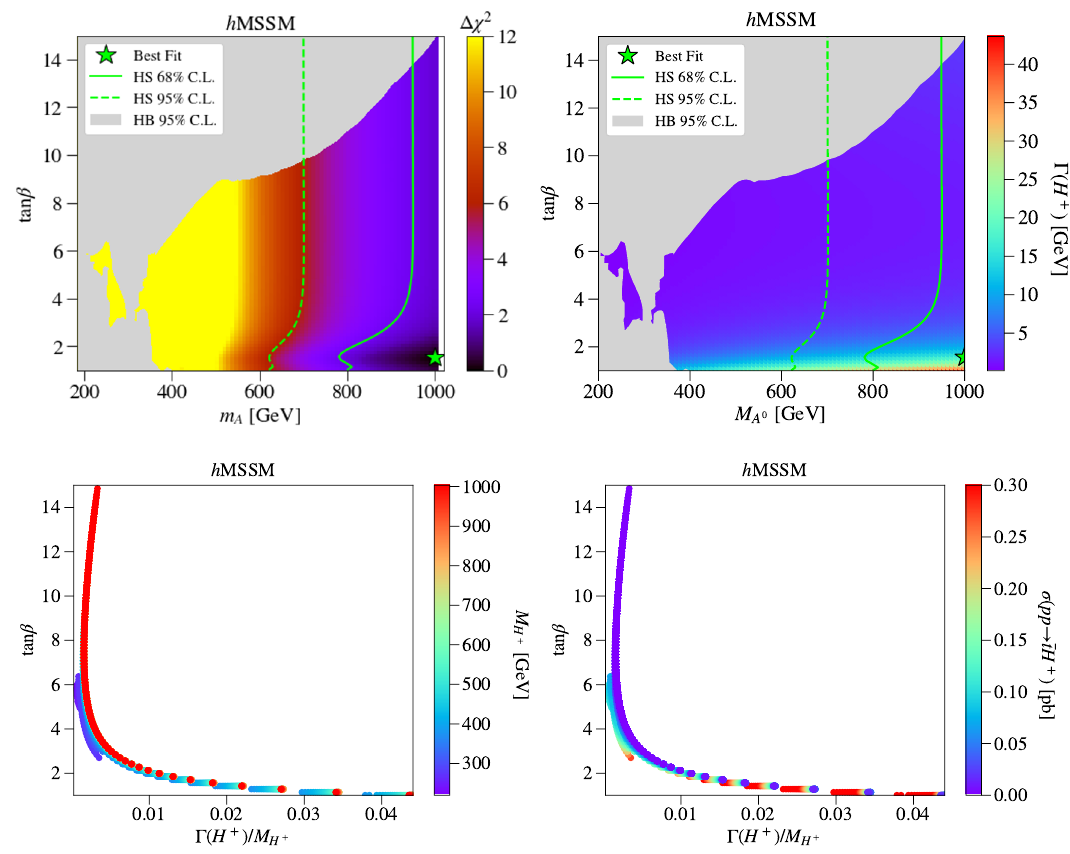
Figure 1 . (cid:1) (cid:31) 2 (top-left) and the charged Higgs total width (top-right) in the ( m A (cid:17) M plane. The best (cid:12)t point is located at M exclusion limits from HiggSignals at 1 (cid:27) (solid) and 2 (cid:27) (dashed) while the gray area is ruled out by the various LHC searches implemented in HiggsBounds. The ratio (cid:0) charged Higgs mass is shown in the bottom-left panel while in the bottom-right one it is presented as a function of the charged Higgs production cross